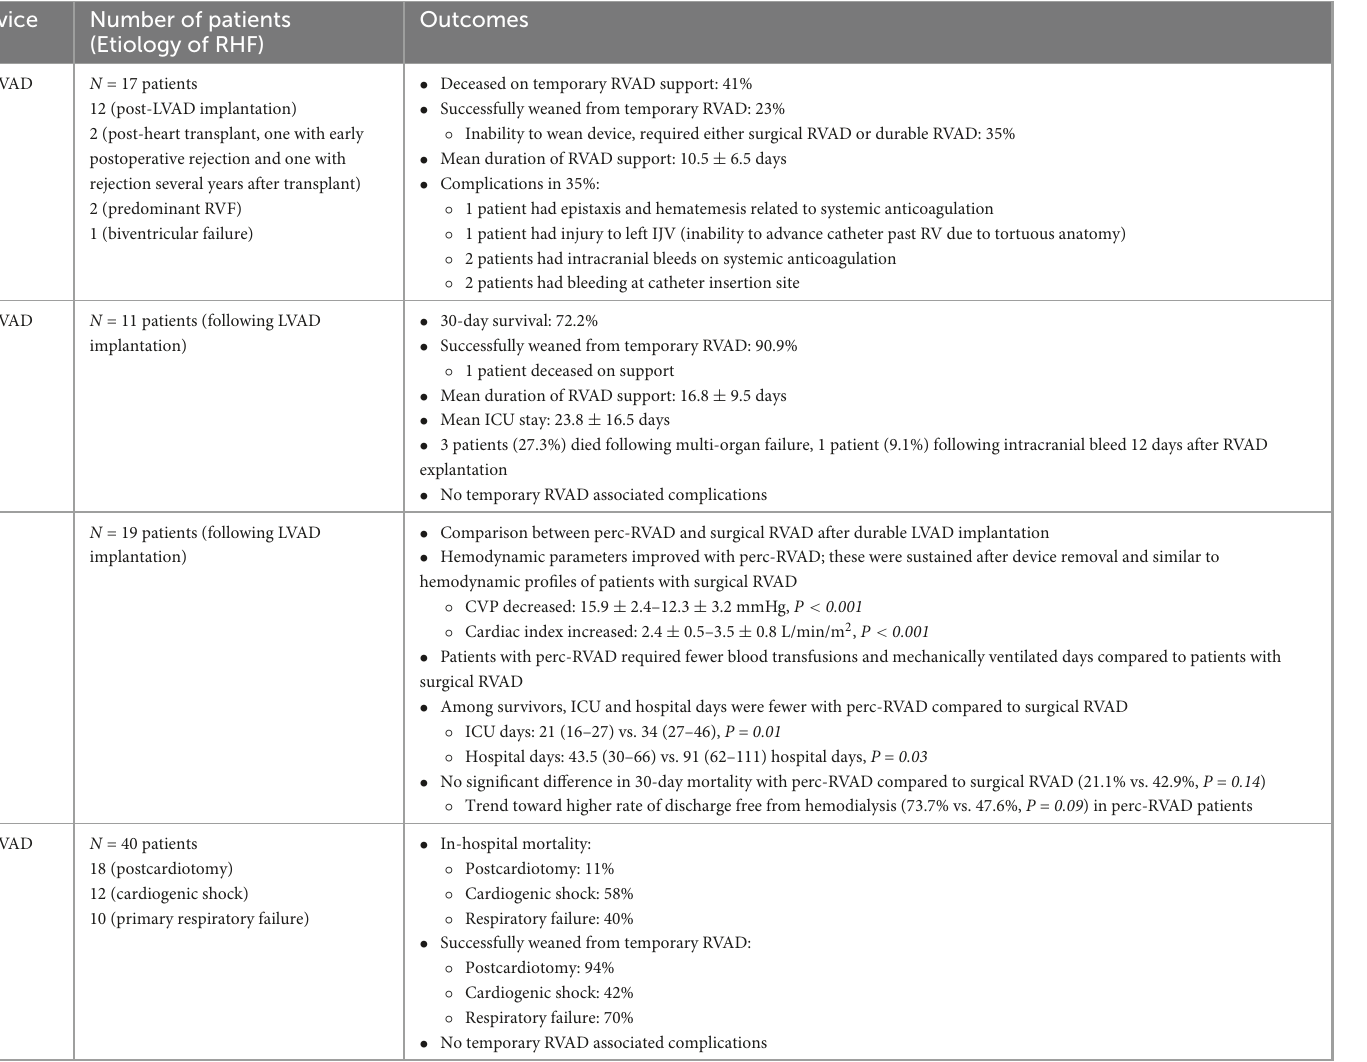
TABLE 3 Experience with percutaneous RVAD for the management of acute right heart